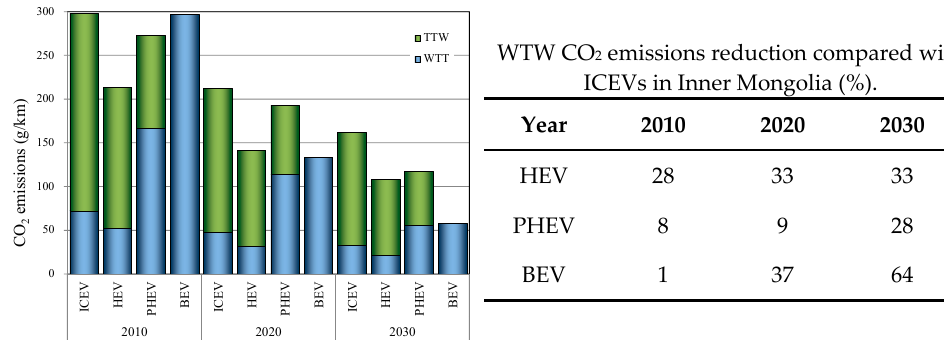
Figure 10. WTW CO 2 emissions of ICEVs/HEVs/PHEVs/BEVs in China.